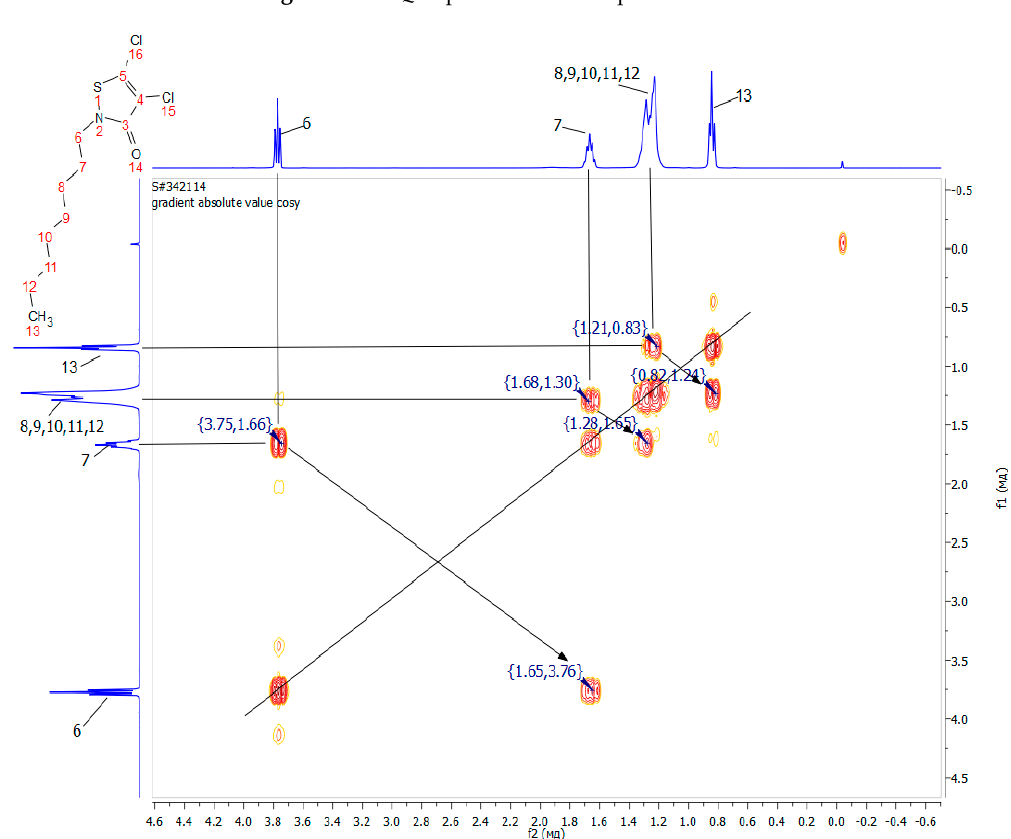
Figure 8. COSY spectrum of DCOIT.